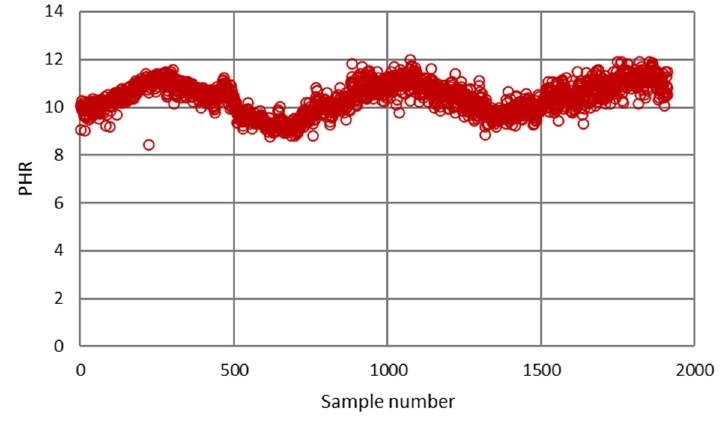
Figure A7. pH value of the pulp in rougher flotation stage (PHR)—input dataset.